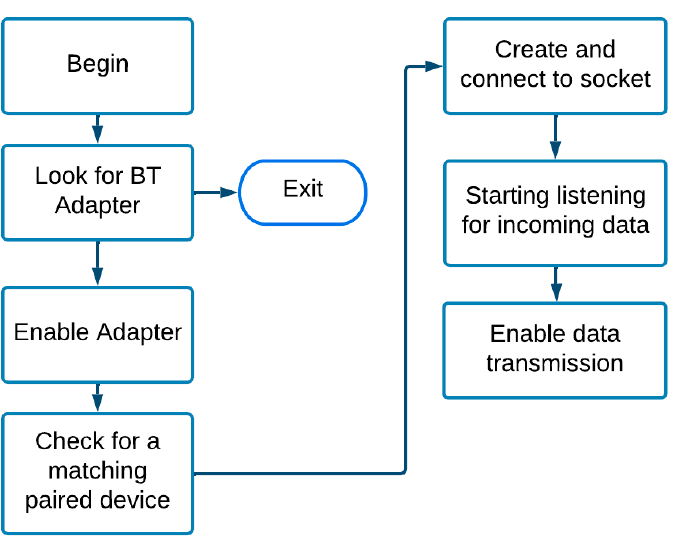
Figure A1. Caption: BLE Theory Flowchart [41].